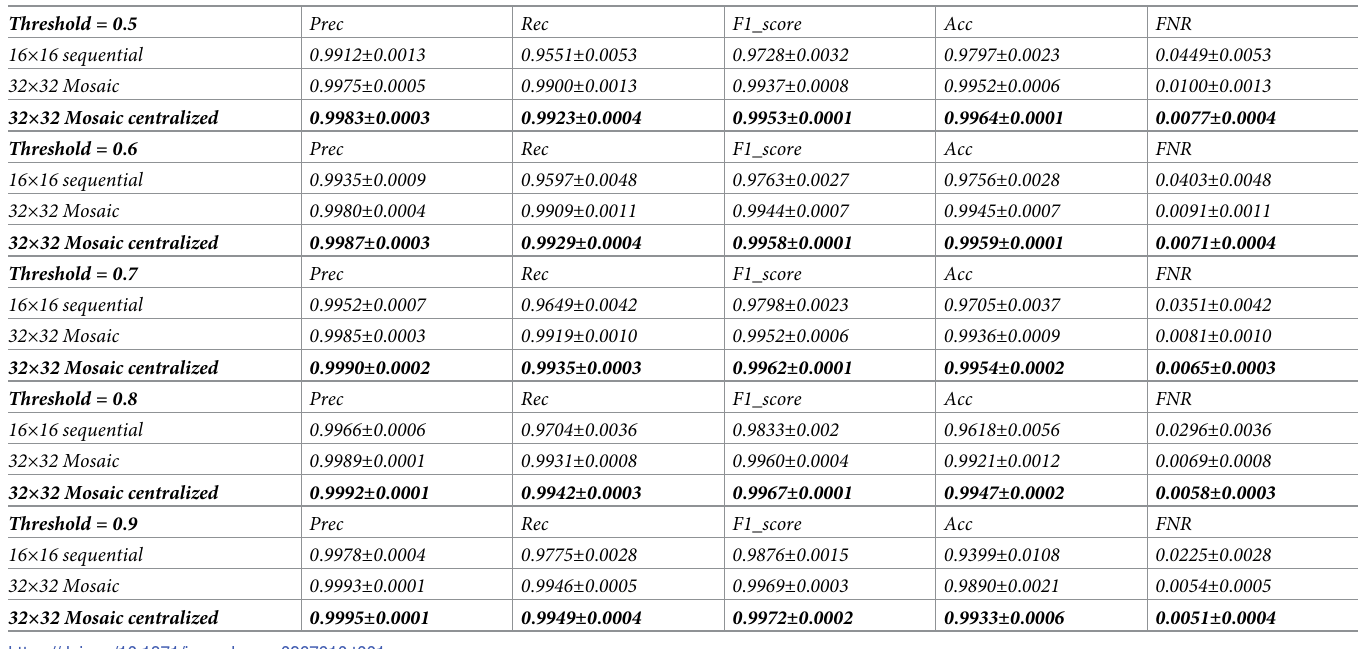
Table 1. The 11-bit CAN ID test results for all four